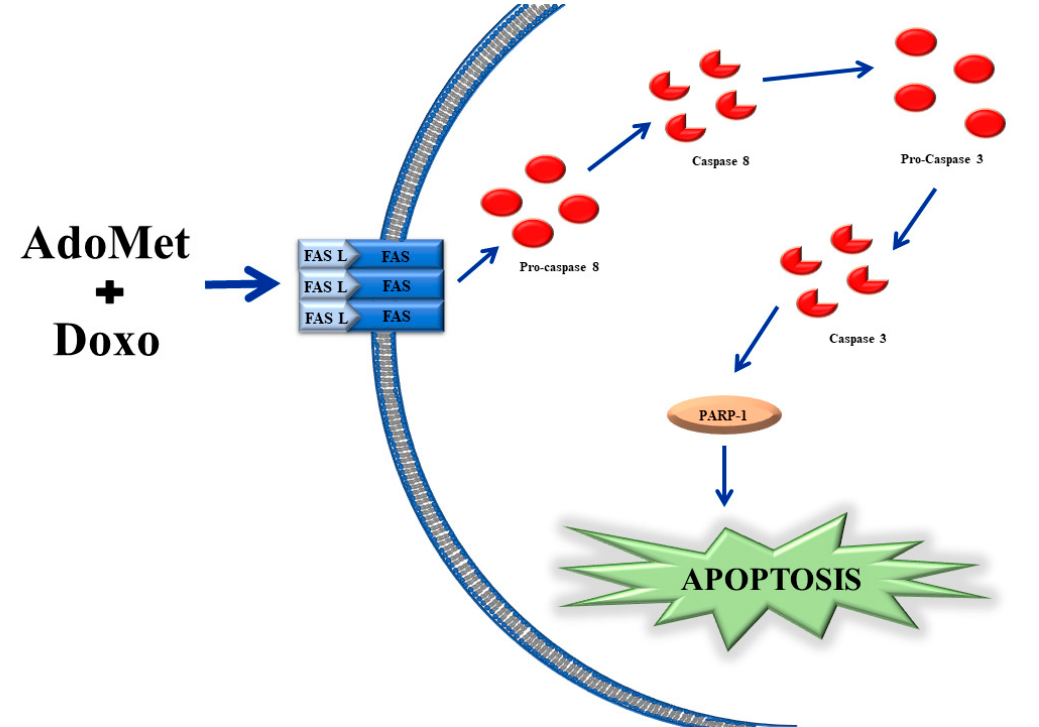
Figure 1. Schematic representation of the mechanism underlying the synergistic antitumor effects of S-adenosylmethionine and doxorubicin in CG5 breast cancer cells. The ability of AdoMet in enhancing the efficacy of Doxo in breast cancer cells is substantiated by evidence indicating that DNA hypomethylation plays a role in the development of Doxo resistance in human breast cancer [57].